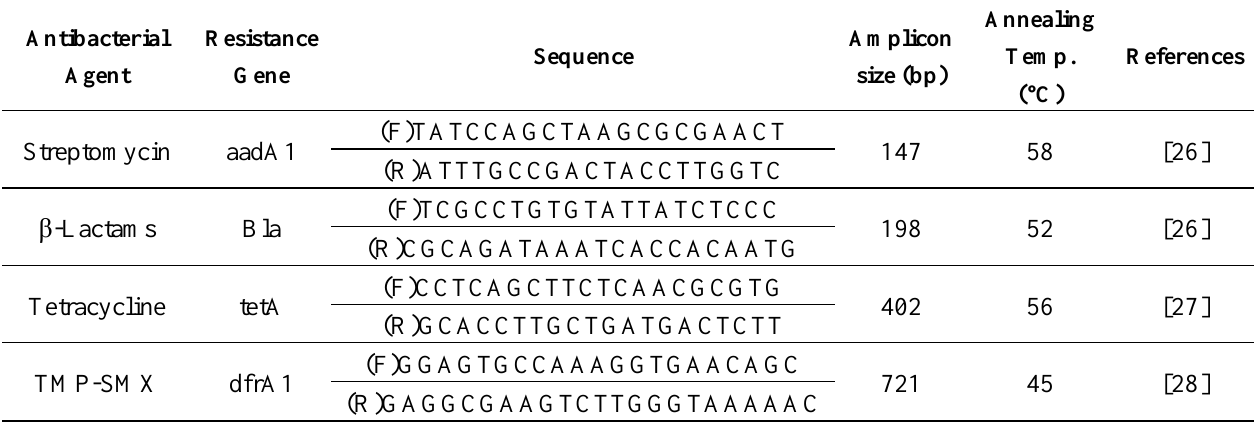
Table 3. Details of target antibiotic resistance genes.